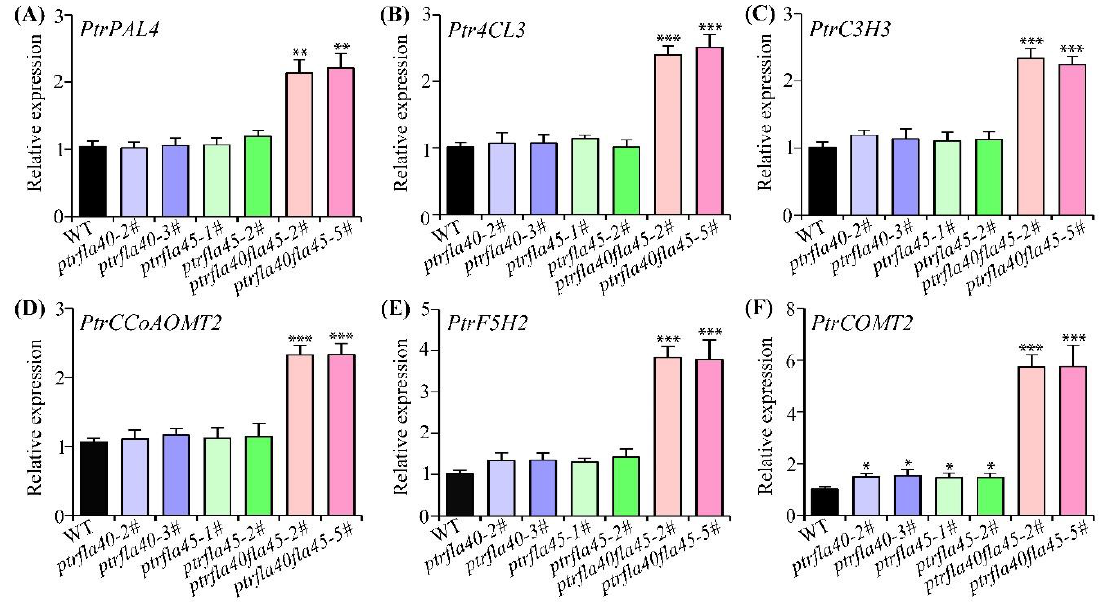
Figure 7. Transcription levels of lignin biosynthesis enzyme genes in wild-type (WT), ptrfla40, ptrfla45, and ptrfla40fla45 mutants by RT-qPCR analysis. ( A – F ) PtrPAL4 , Ptr4CL3 , PtrC3H3 , PtrC- CoAOMT2 , PtrF5H2 and PtrCOMT2 were quantitatively detected in stems of WT, ptrfla40, ptrfla45, and ptrfla40fla45 mutants. PtActin2 was used as an internal control. PAL, phenylalanine ammonia- lyase; 4CL, 4-coumarate: CoA ligase; C3H, p -coumarate 3-hydroxylase; CCoAOMT, caffeoyl-CoA O-methyltransferase; F5H, ferulate 5-hydroxylase; COMT, caffeic acid O-methyltransferase. Data are means ± SD ( n = 3 ). Student’s t -test: *, p < 0.05; **, p < 0.01; ***, p < 0.001.